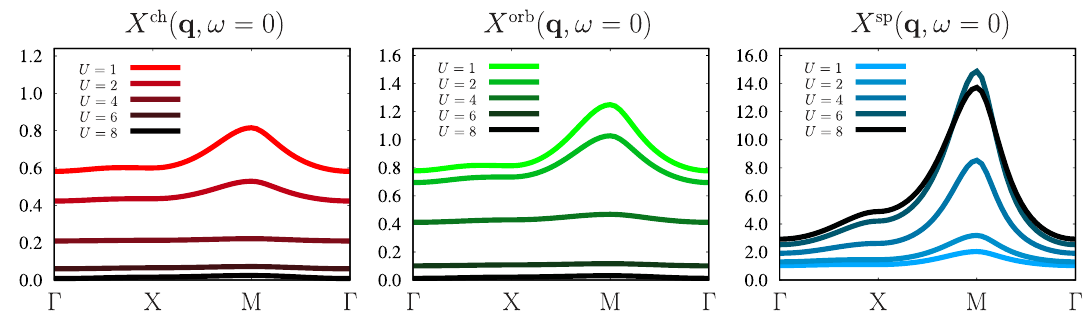
Figure 9: Charge (left), orbital (center) and spin (right) components of the static susceptibility X ( q , ω = 0 ) computed along the high-symmetry path in momentum space. Calculations are performed for the half-filled Hubbard-Kanamori model for different values of U fixing other parameters to β = 2, U (cid:48) = U / 2, and J = U /